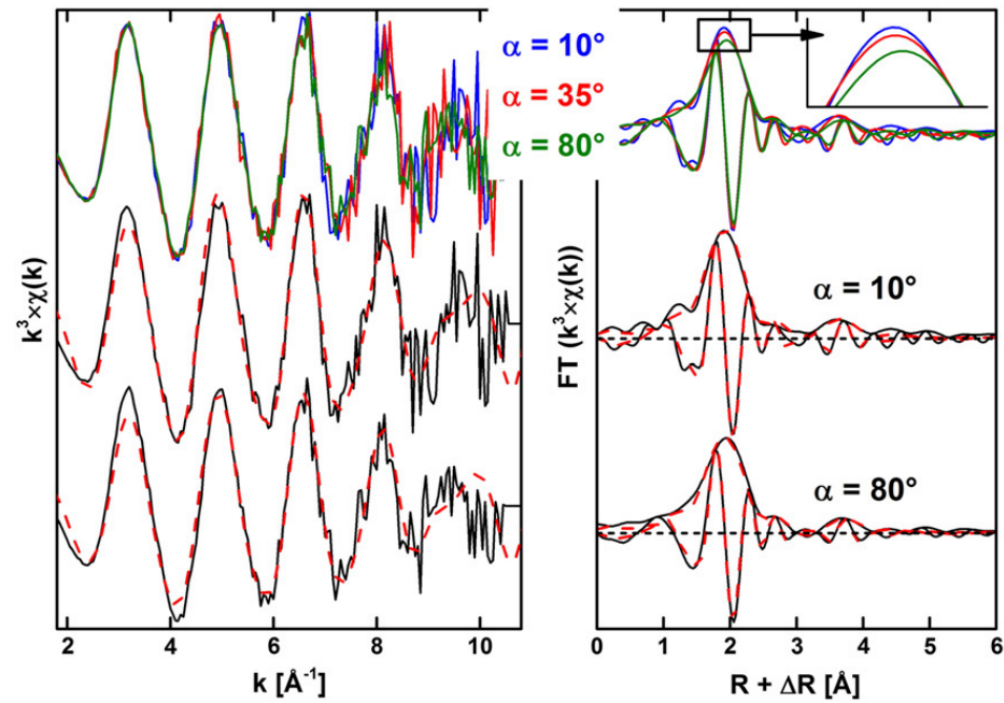
Figure 6. Polarized EXAFS spectra ( left ) and the corresponding Fourier transforms ( right ) of AmCopBru. Reprinted with permission from ref. [42]. Copyright 2021 Elsevier.